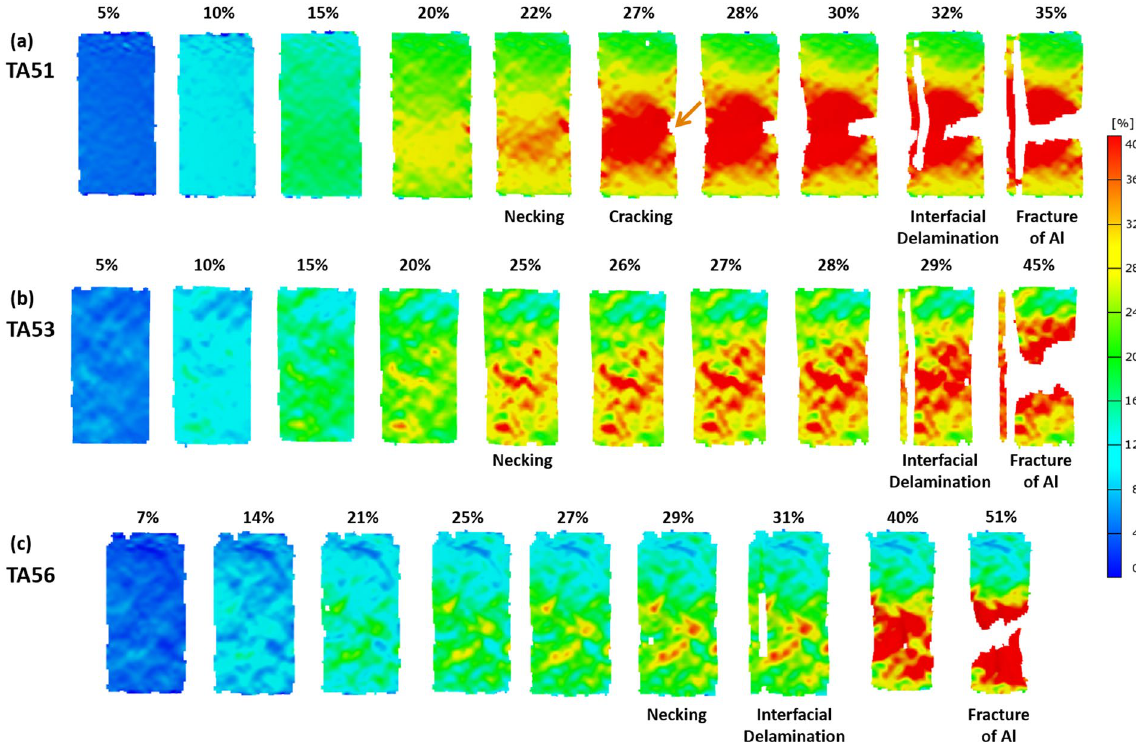
Figure 7. Digital images of strain distribution taken during tensile tests. Digital images of the ( a ) TA51, ( b ) TA53, ( c ) TA56 specimens. Strains at the necking, cracking, and interfacial delamination points are described above each digital